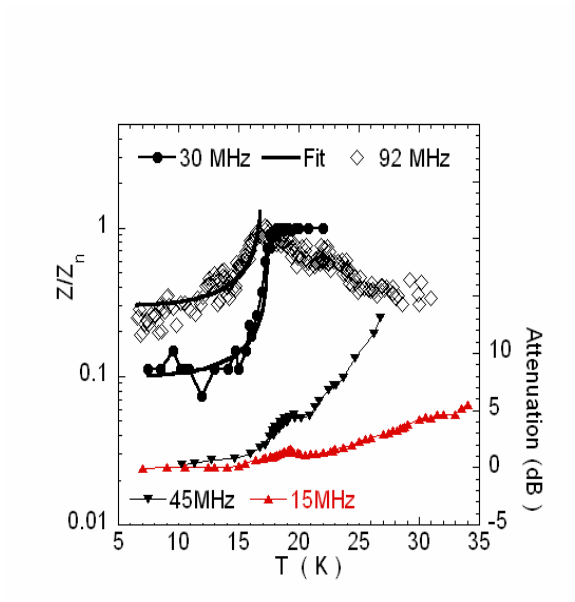
Fig 3 BaFe 1.93 Ni 0.07 As 2 crystal .Temperature dependence of the normalized impedance Z/Zn, non resonant circuit at 30 MHz, resonant circuit at 92MHz. The solid lines (Fit) are calculated with equation (4) with Tc= 17.5K, and Tc=18K.Temperature dependence of the ultrasonic attenuation at 15 and 45